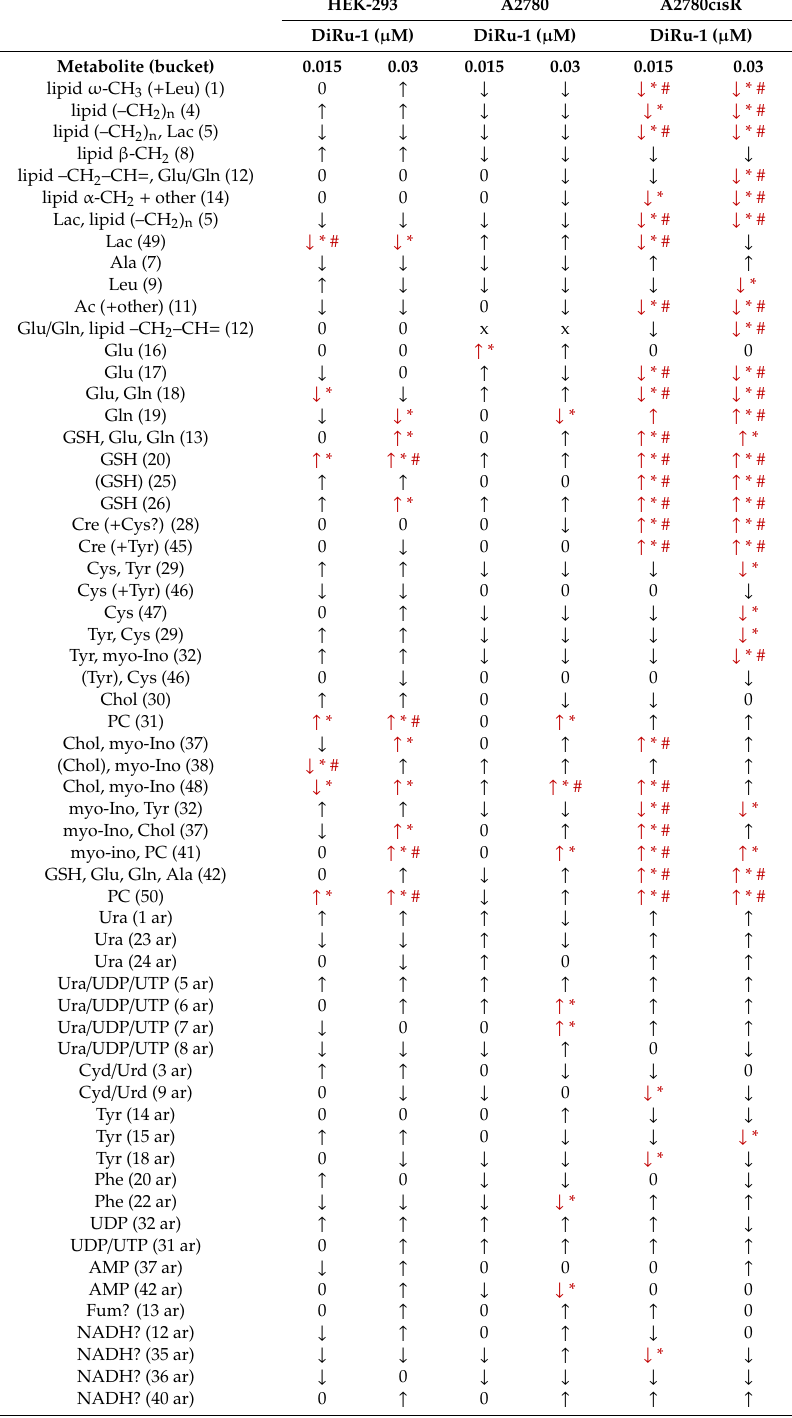
Table 3. Up- or downregulated metabolites upon treatment with DiRu-1. * indicates that the changes observed were significant with a p -value < 0.05. The buckets marked with # show Benjamini–Hochberg-corrected p -values < 0.05. Abbreviations: ar = buckets in aromatic region; Ac = acetate; Ala = alanine; AMP = adenosine monophosphate; Chol = choline; Cre = creatine; Cyd